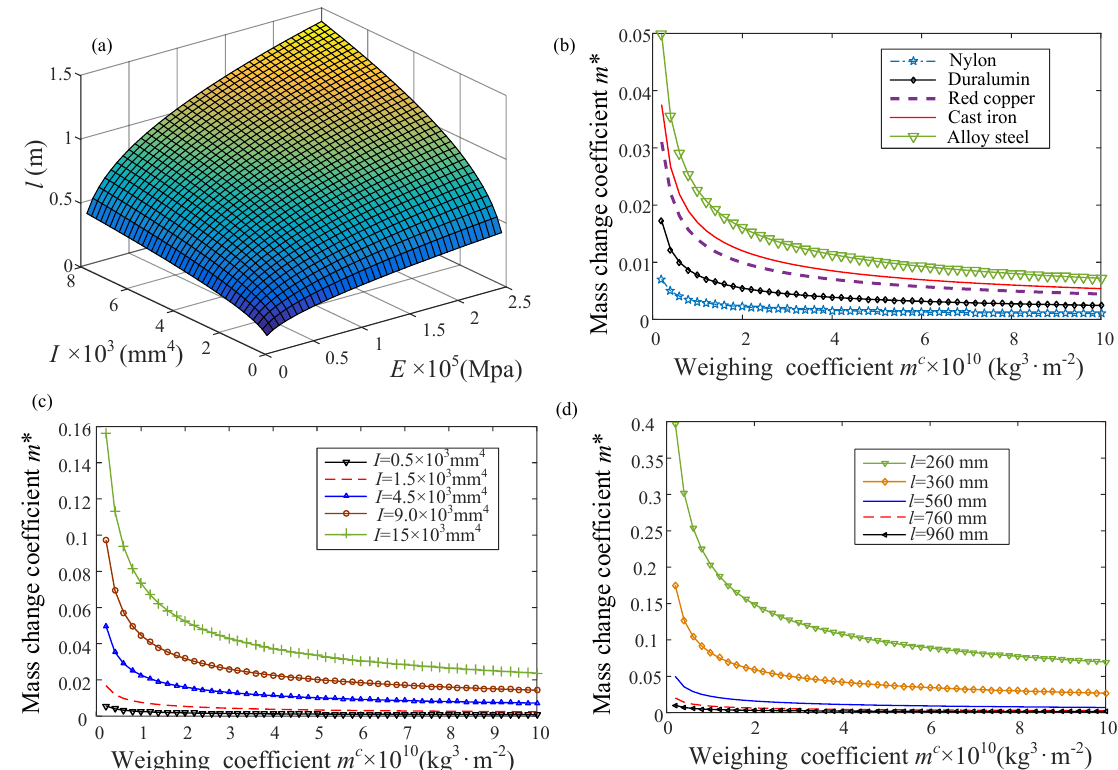
Figure 6. Influence of connected piping parameters on the mass change coefficient: ( a ) characteristic parameter relationship; ( b ) materials; ( c ) moment of inertia; ( d ) length.